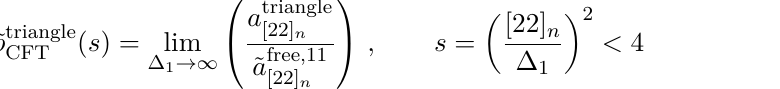
( s ) for m 2 = 2 / 3 2 CFT